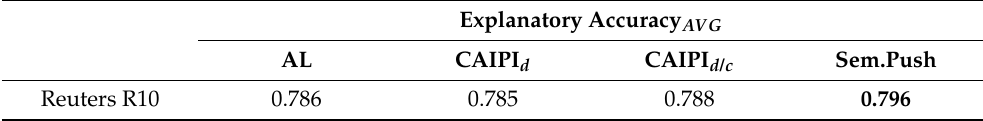
Table 4. Local explanation quality with respect to ‘Ground Truth’ of downstream classification task (with SVM as the base